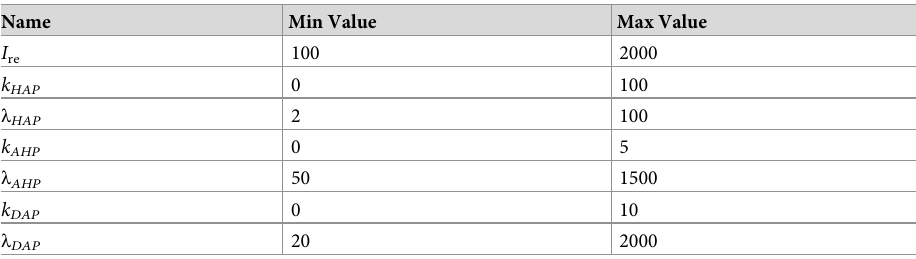
Table 2. Single neuron model fitting parameter